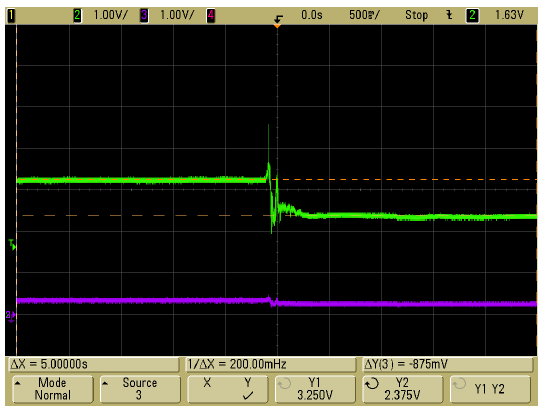
Figure 14. Response to the weights.